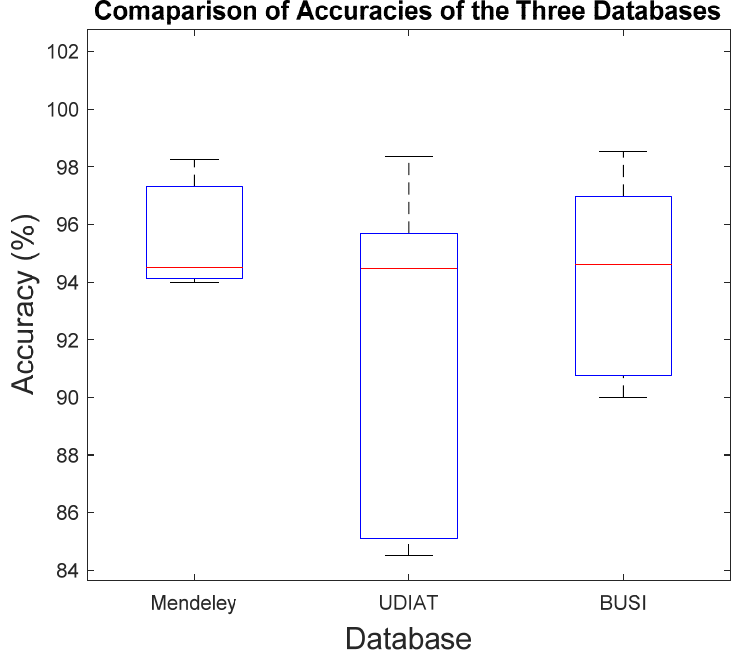
Figure 10. Comparison of accuracies of the three databases from Table